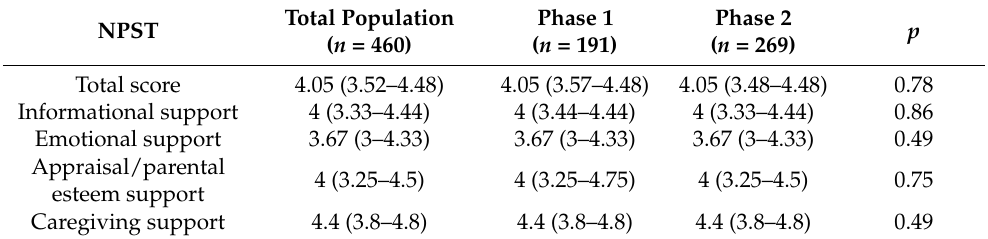
Table 5. NPST median scores: comparison between Phase 1 and Phase